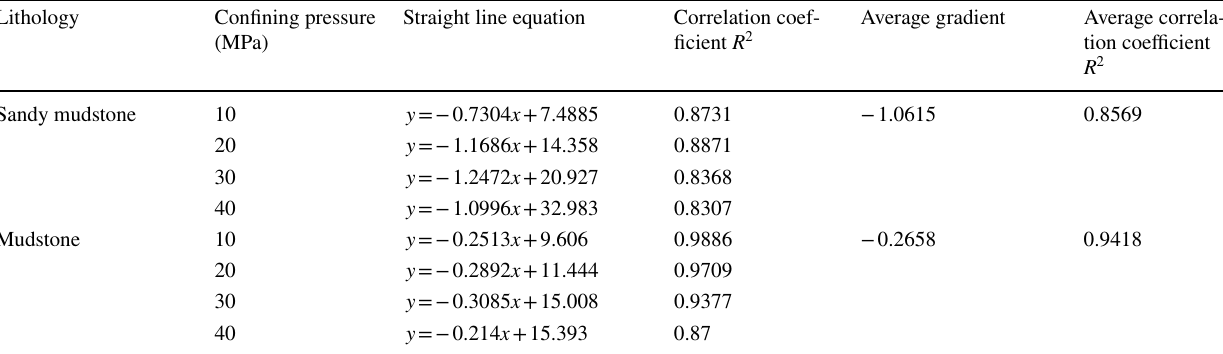
Table 2 Parameters of cohesion reduction trend fitting curve